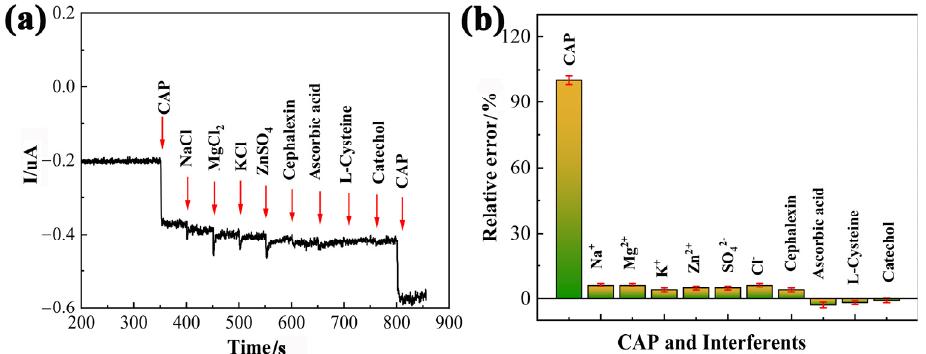
Figure 10. Interference investigation of the PDPP/GO/GCE by i-t test technique ( a ) and histogram of the selectivity toward interferents ( b ). of the selectivity toward interferents ( b ).